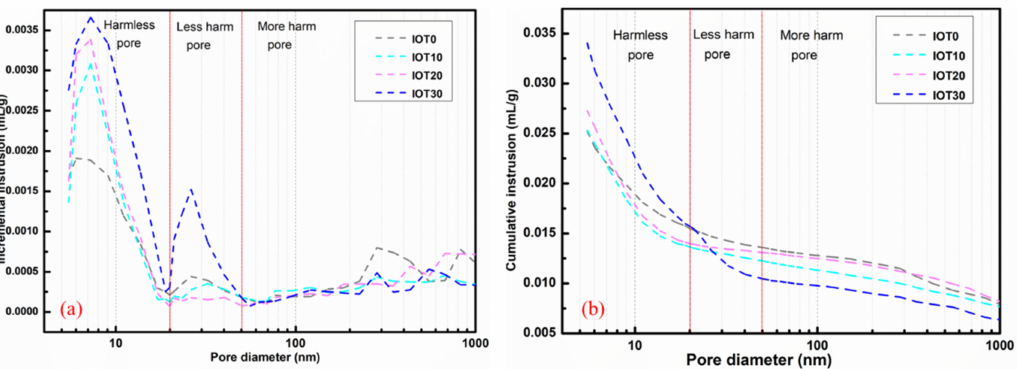
Figure 10. Effect of iron ore tailing on the pore size distribution of designed UHPC at 28 d: ( a ) Incremental intrusion; ( b ) cumulative